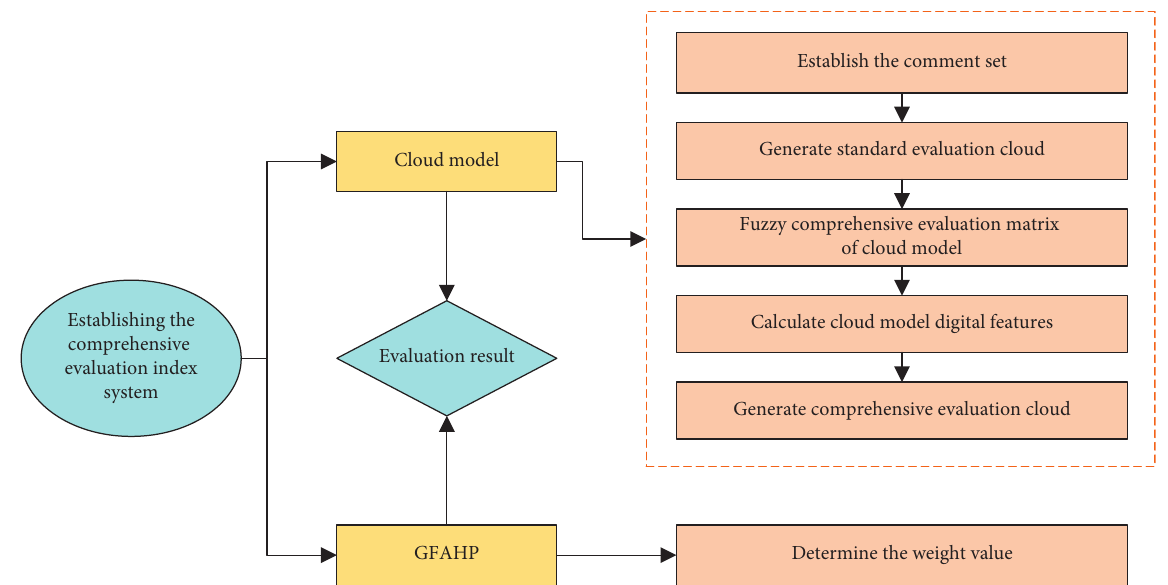
Figure 4: Flow chart of cloud model fuzzy comprehensive evaluation method. Table 3: Calculation results of evaluation index weight.